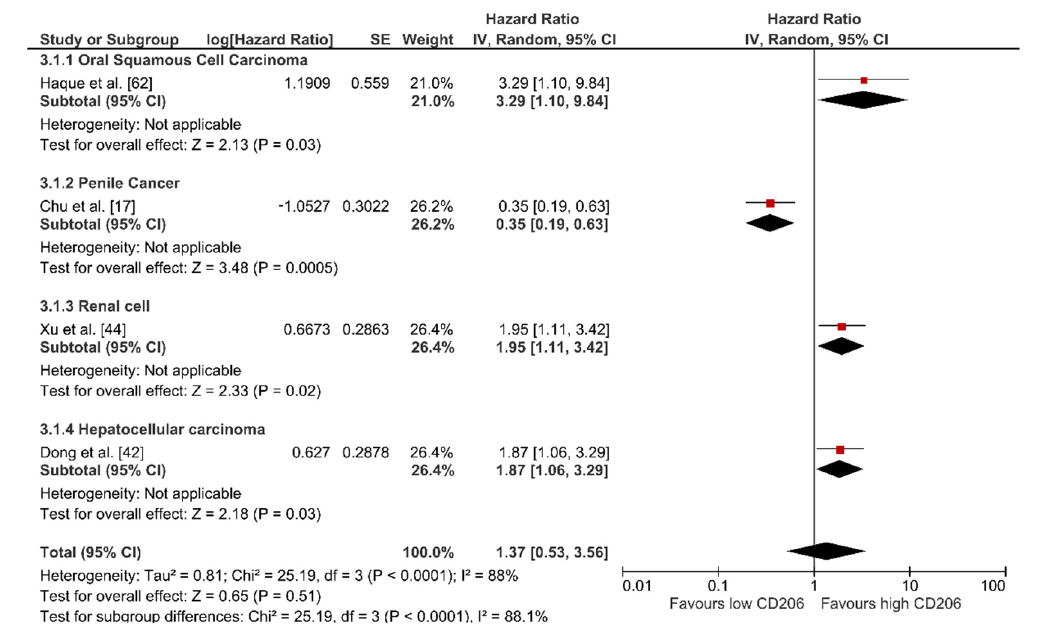
Figure A3. Forrest plot of impact of CD206-expression on disease specific survival of patients diagnosed with solid cancers. SE: standard error; IV: Interval variable; CI: confidence interval; df: degrees of freedom.